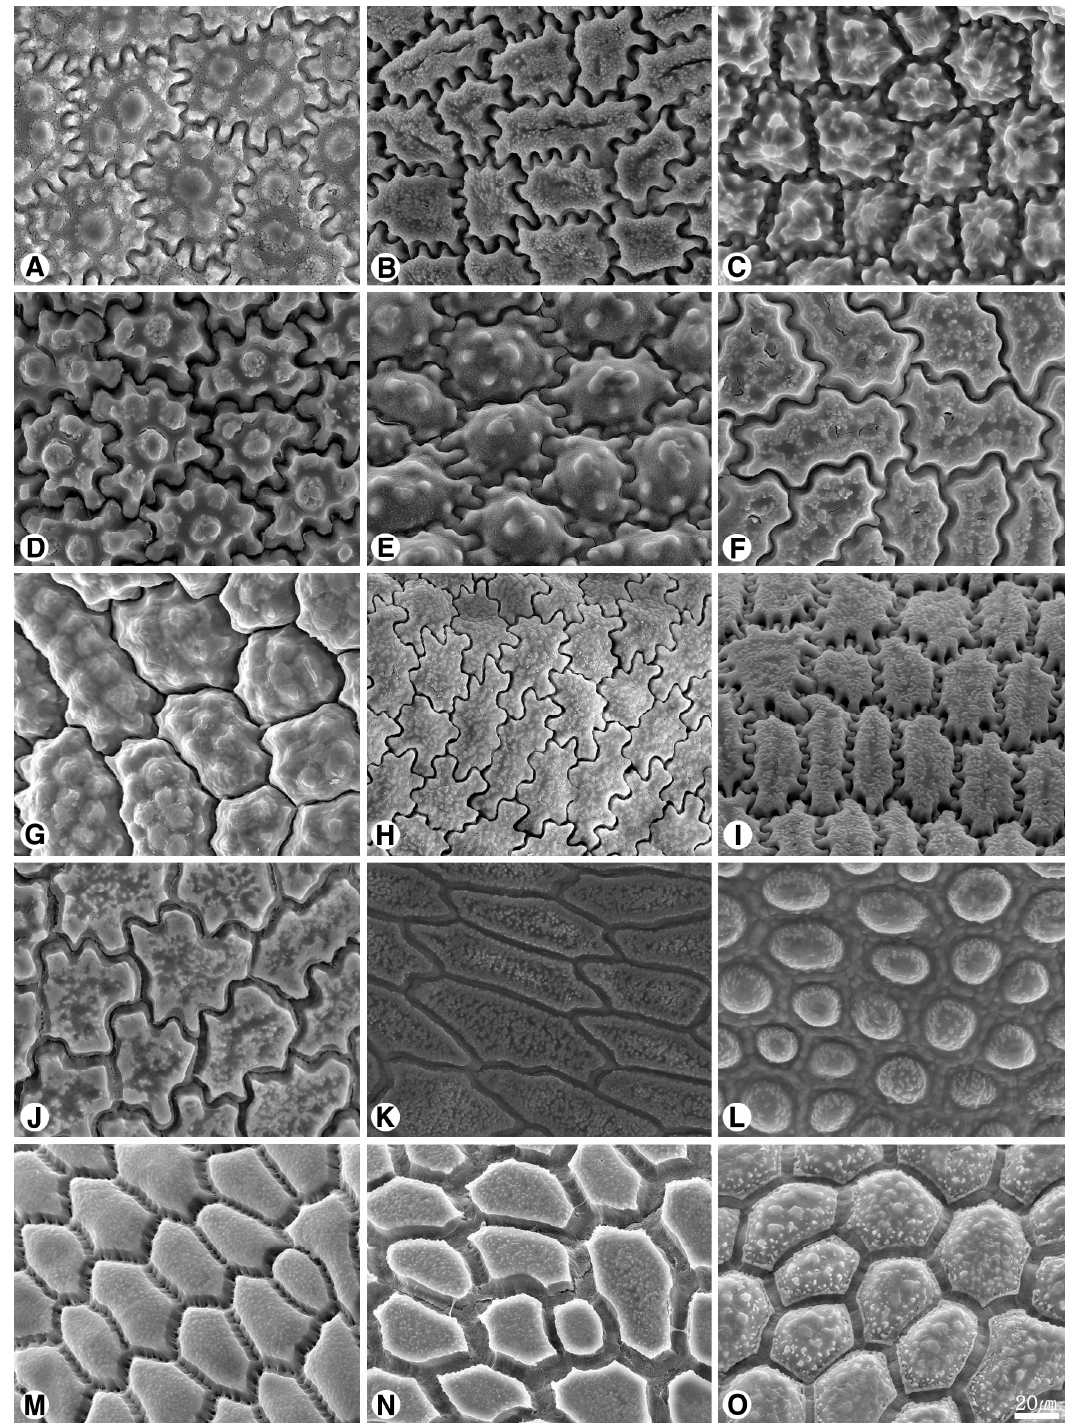
Figure 5. Scanning electron micrographs of seed testa in Allium . ( A – I ) subg. Allium : ( A ) A . filidens (sect. Allium ); ( B ) A. caesium “101a”; ( C ) A . caesium “101b”; ( D ) A . caeruleum ; ( E ) A . svetlanae ; ( F ) A . tatyanae (sect. Caerulea ); ( G ) A . turkestanicum (sect. Mediasia ); ( H ) A . anisotepalum (sect. Minuta ); ( I ) A . pallasii (sect. Pallasia ); ( J , K ) subg. Butomissa : ( J ) A . oeroprasum (sect. Austromotana ); ( K ) A . ramosum (sect. Butomissa ); ( L – O ) subg. Cepa : ( L ) A . fedschenkoanum (sect. Annuloprason ); ( M ) A . altaicum ; ( N ) A . galanthum ; ( O ) A . oschaninii (sect. Cepa